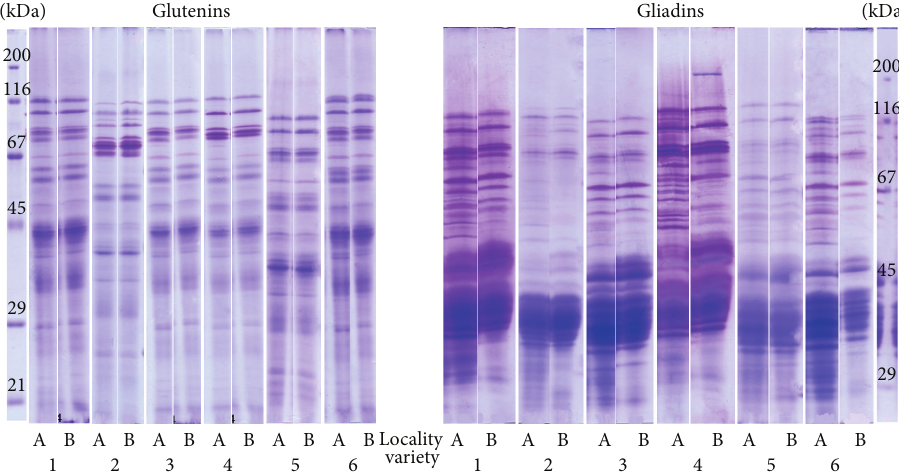
Figure 2: Glutenins and gliadins electropherograms of examined wheat varieties (1–6) from observed localities (A and B).